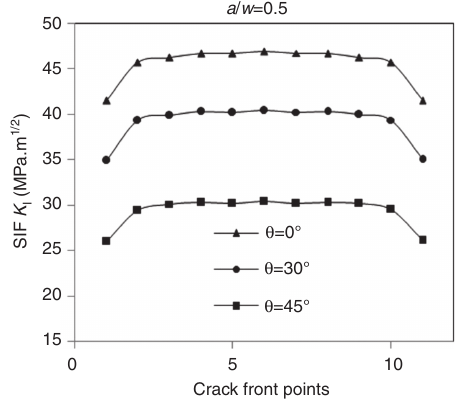
Figure 16 Effect of crack angle on K